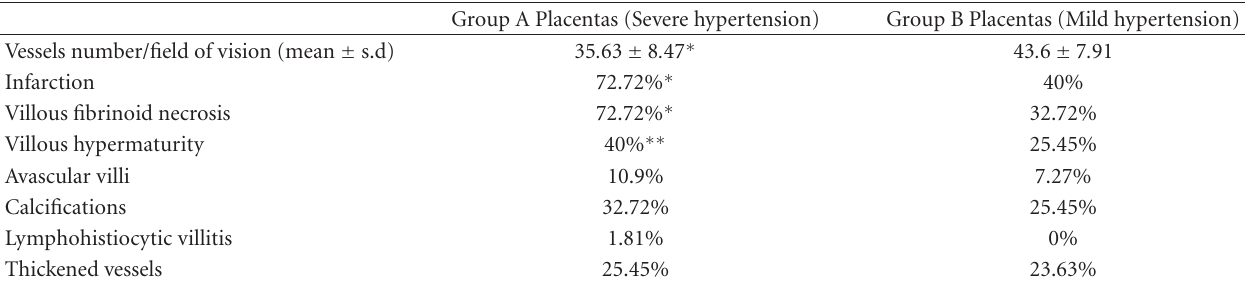
Table 2: Findings of histomorphological examination of placentas in severe hypertension group A versus mild hypertension group B. Group A Placentas (Severe hypertension) Group B Placentas (Mild hypertension) Vessels number/field of vision (mean ±